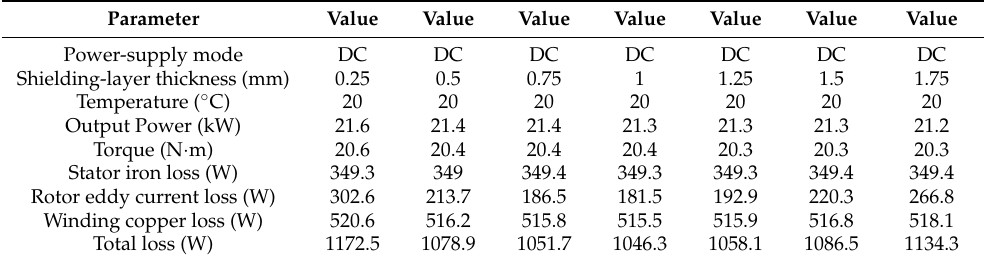
Table 5. Motor-loss data with different shielding-layer thicknesses at 20 ◦ C. Parameter